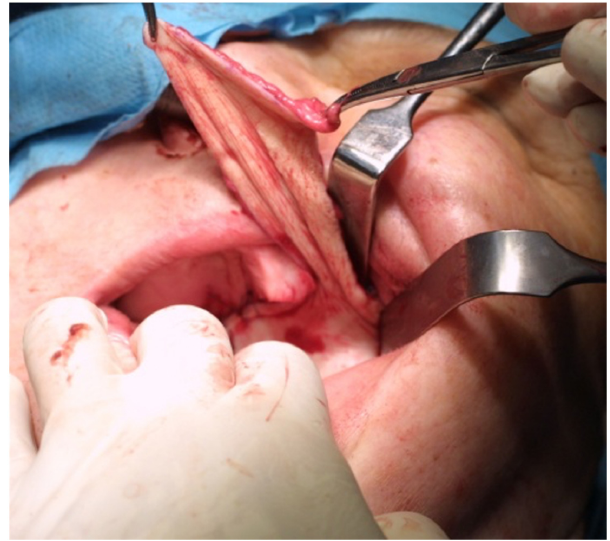
Figure 2. Full-thickness skin graft sewing.